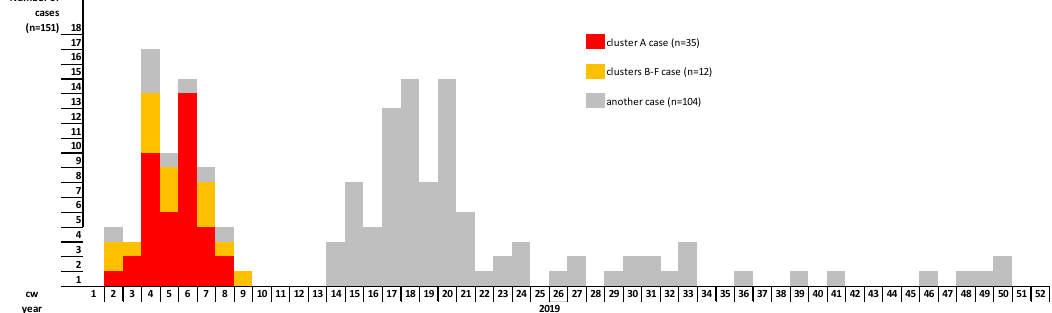
Figure 6. Measles (confirmed and probable) cases according to calendar week of symptom onset and cluster allocation, Austria, 2019 (n = 151).